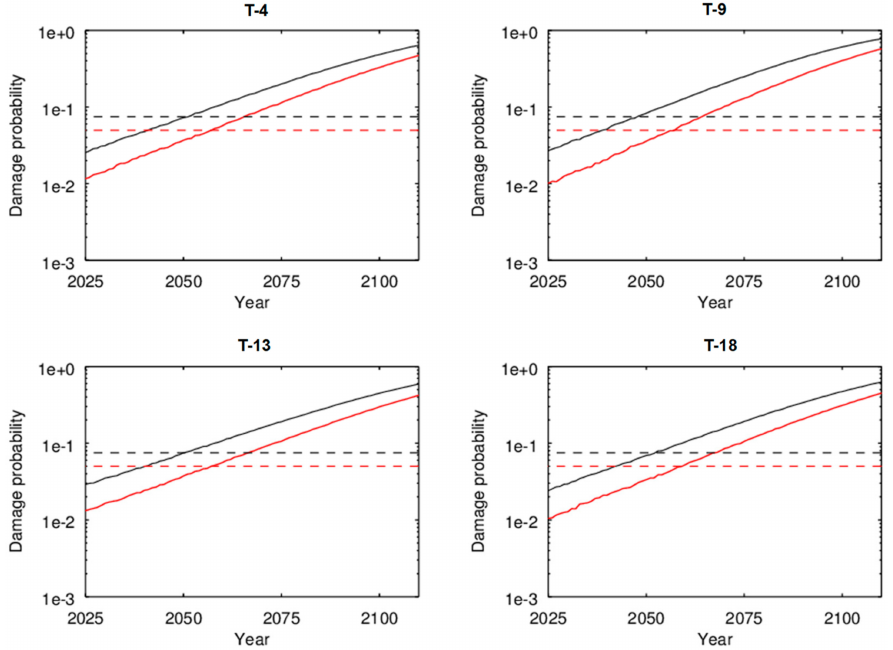
Figure 20. The annual probability of damage at the EOSL for selected profiles in Trincomalee (continuous lines) and the probability of damage above which retreat is optimal (dashed lines). The optimal investment horizon at the EOSL is found where these lines cross. Results for r = 15% per year in black; results for r = 10% per year in